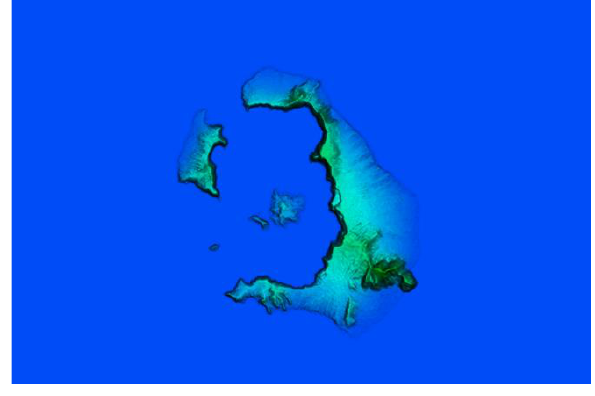
Figure 4. Digital elevation model of Santorini island, as obtained by